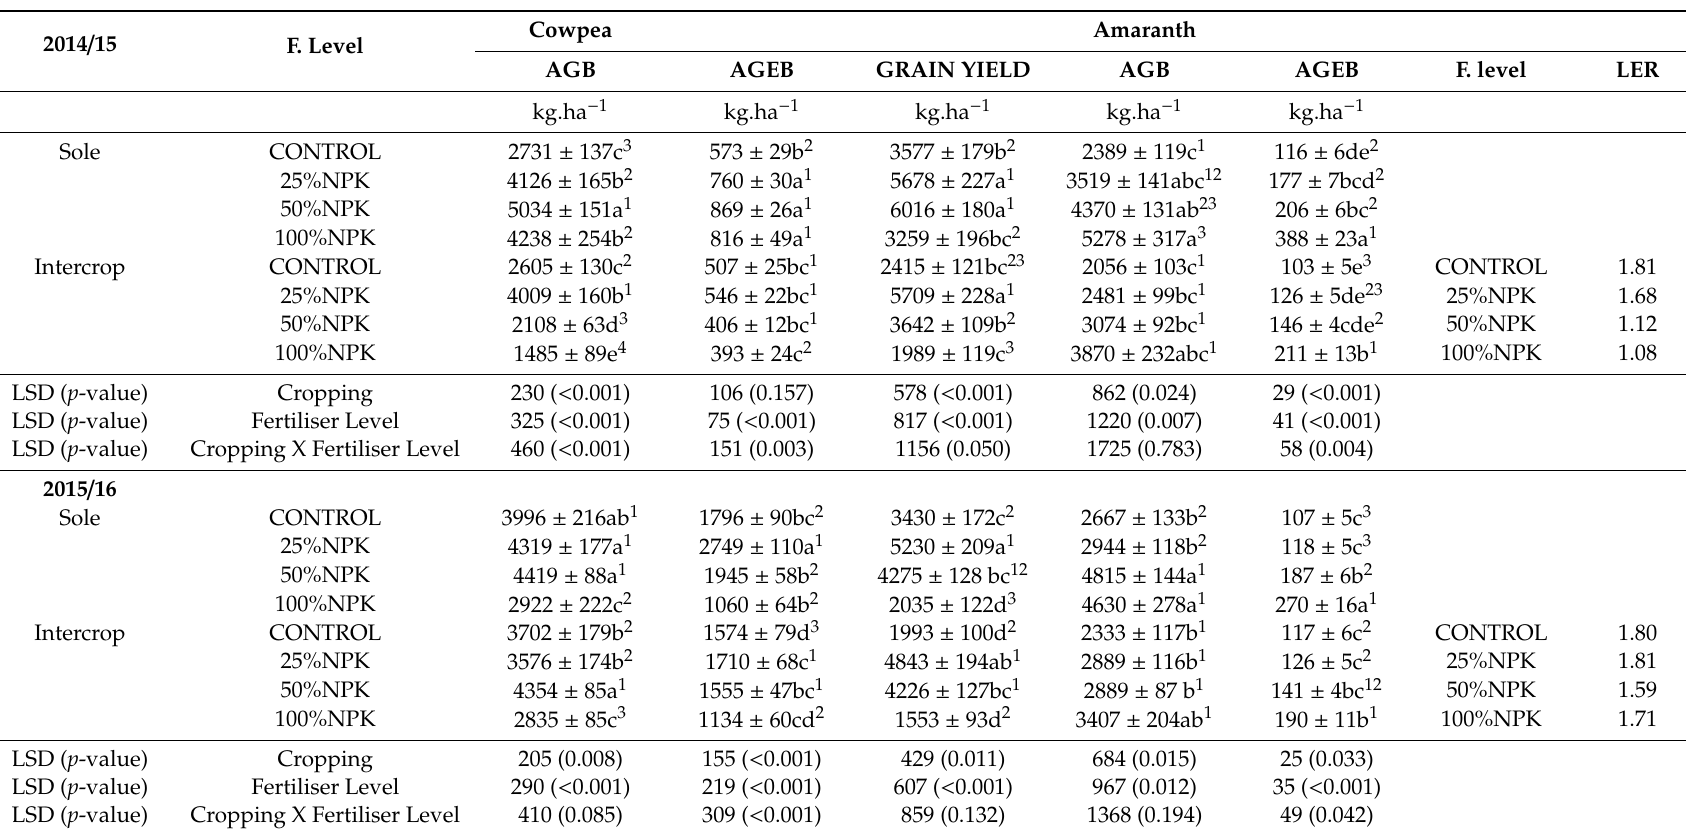
Table 5. Above ground biomass (AGB), above ground edible biomass (AGEB), in cowpea and amaranth under sole and intercropping systems as well as Land Equivalent Ratio (LER) and grain yield of cowpea at four fertiliser levels (F. level) (NPK) in 2014 / 15 (season 1) and 2015 / 16 (season 2)